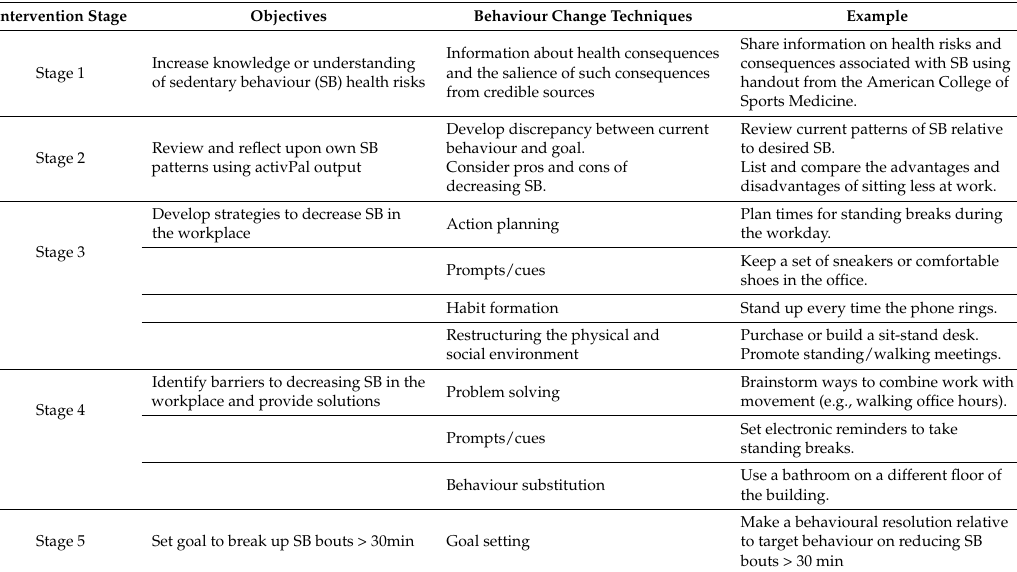
Table 1. Behavioural